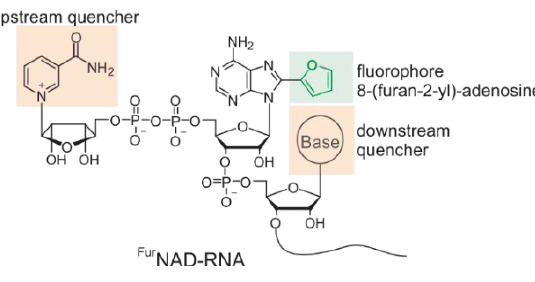
Figure 2. Illustration of Fur NAD-RNA.